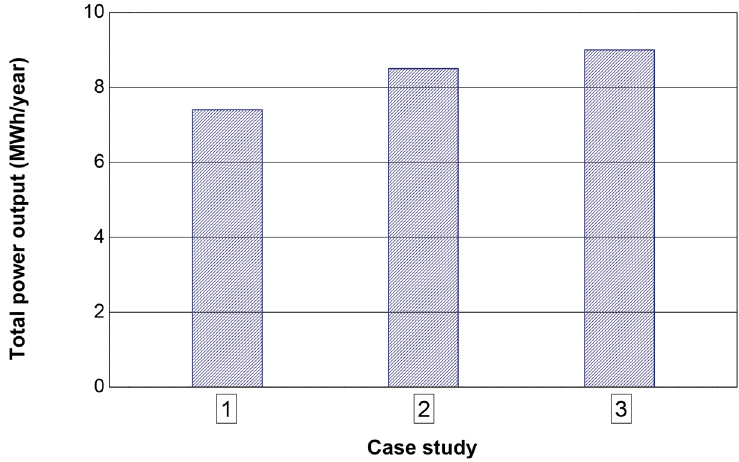
Figure 11. Annual amount of generated electricity for case study.